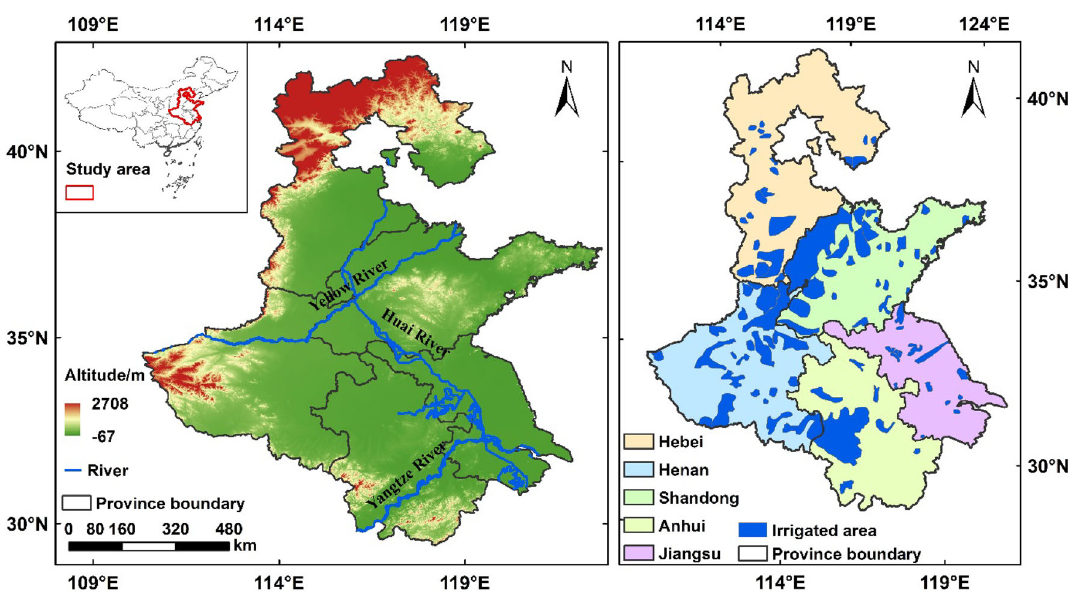
Fig. 1 Topography, water system, and irrigation areas of the five-province study region in